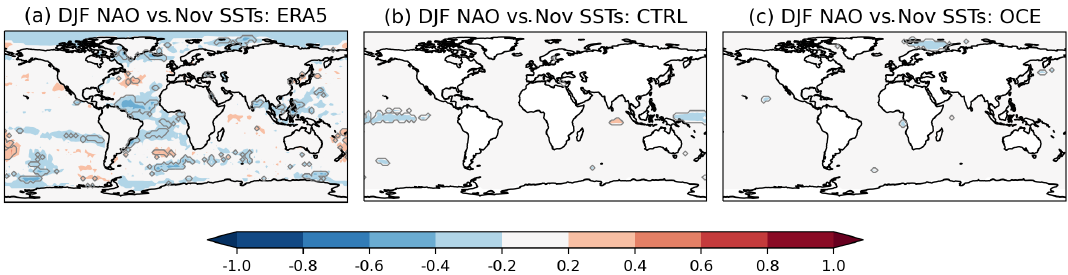
Figure B9. Correlations between detrended November SSTs at each grid point and the DJF NAO time series for (a) ERA5, (b) CTRL, and (c) OCE. The ensemble members of the CTRL and OCE experiments have been concatenated together. The period covered is 1980–2015. The grey contour highlights statistically significant correlations ( p < 0 .